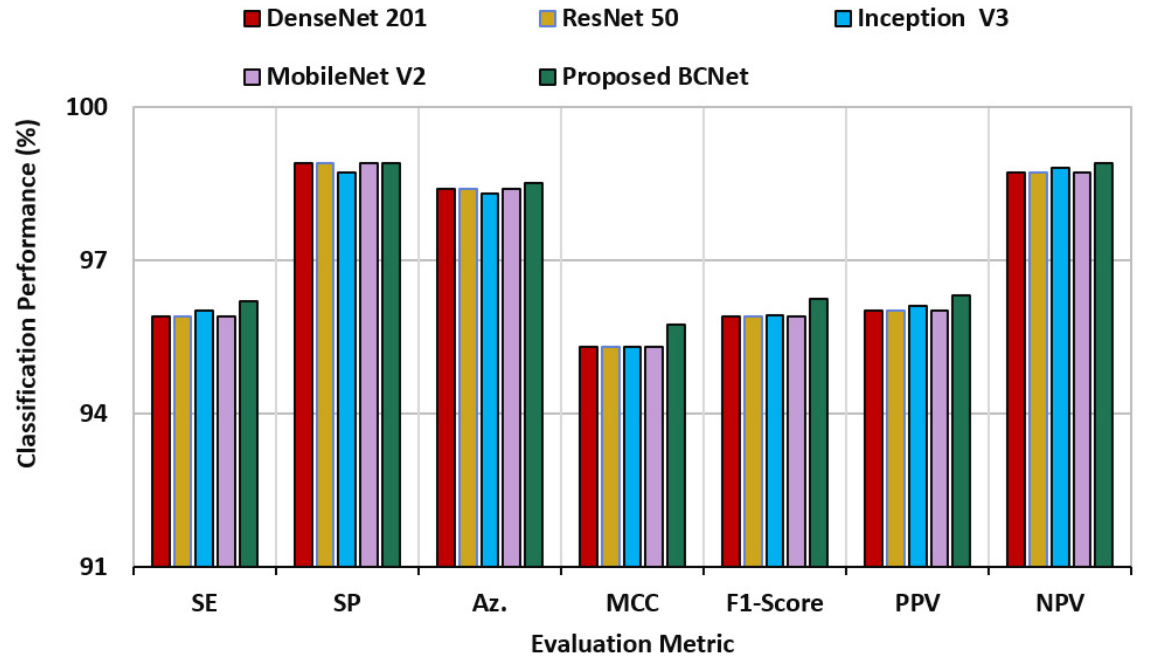
Figure 7. Direct comparison results of blood cell classification using the proposed BCNet and other deep learning models of DenseNet 201, ResNet50, Inception-V3, and Mobilenet-V2.